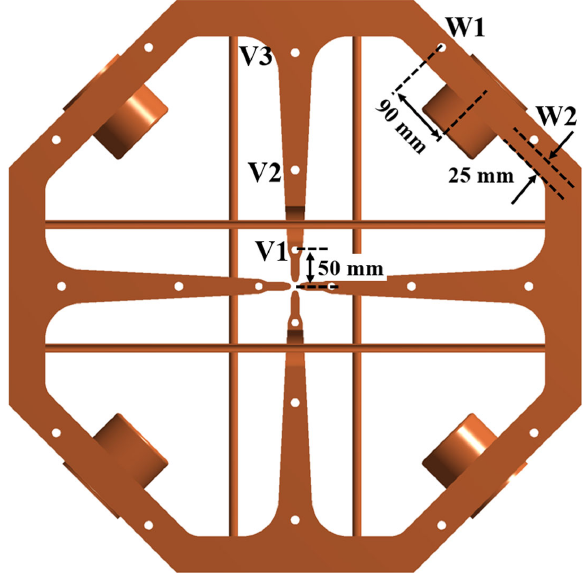
FIG. 22. Layout of the HIAF RFQ cooling channels.